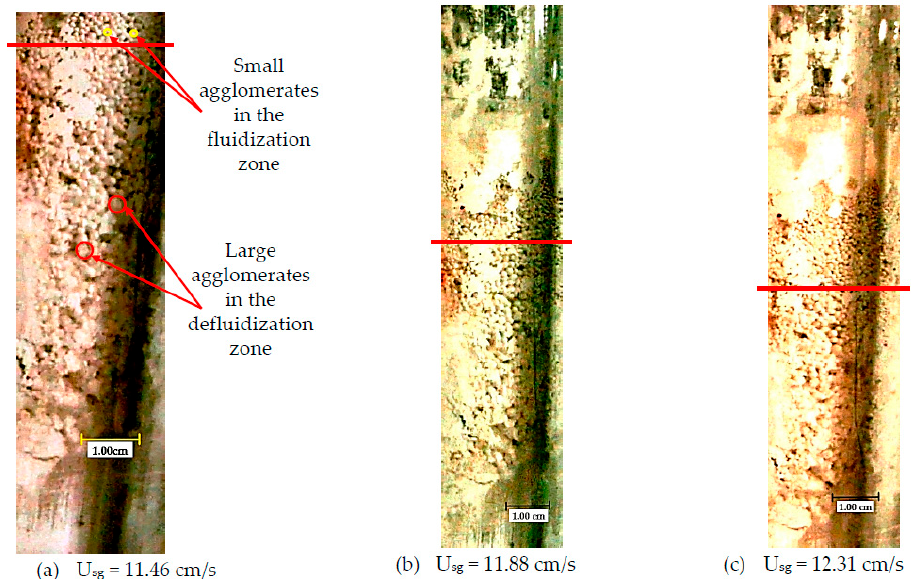
Figure 21. Cropped sections of an active channel near the wall during a fluidization test of ultra-fine material for three different values of superficial gas velocity. The red line is used as a separator of two fluidized and de-fluidized zones (Above the line: fluidized; Below the line: de-fluidized). ( a ) This figure is a zoomed-in capture for a better view of formed agglomerates at lower velocity, 11.46 cm/s; ( b ) The formed agglomerates for whole domain at 11.88 cm/s; ( c ) Changes in the agglomerates’ size and shape as well as thickness of de-fluidized zone by increasing the superficial gas velocity to 12.31 cm/s.